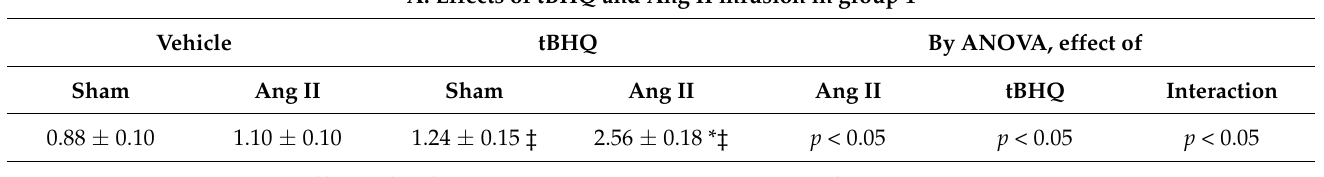
Table 2. Renal excretion of 8-isoprostane F 2 α relative to creatinine in conscious mice.